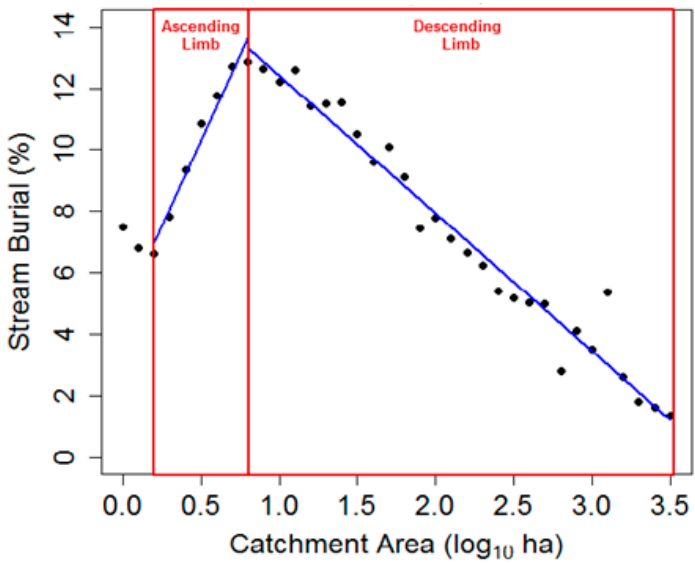
Figure 3. Distribution of burial by catchment area for Montgomery County, Maryland, USA; values of local minima and maxima are indicated by vertical red lines. Regression lines for burial data on the ascending limb (R 2 = 0.96; p < 0.001) and descending limb (R 2 = 0.97; p < 0.001) are indicated in blue. Similar regression analyses were performed for all counties and development tiers.